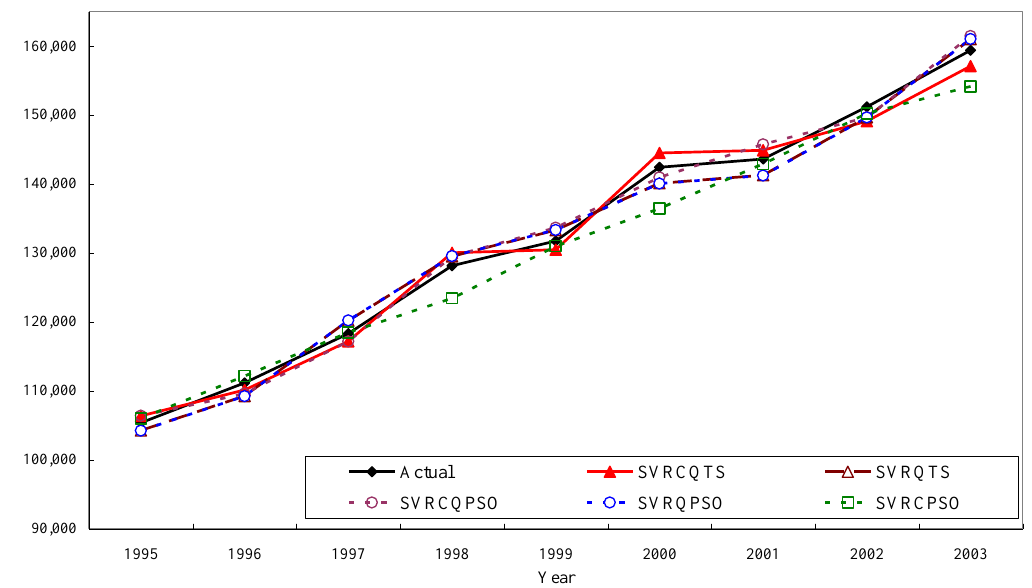
Figure 3. Actual values and forecasting values of SVRCQTS, SVRQTS, and other models (Example 2). SVRCQTS: support vector regression chaotic quantum Tabu search; SVRQTS: support vector regression quantum Tabu search. Table 4. Parameters determination of SVRCQTS and SVRQTS models (Example 2). PSO: particle swarm optimization; CPSO: chaotic particle swarm optimization; QPSO: quantum particle swarm optimization; CQPSO: chaotic quantum particle swarm optimization.